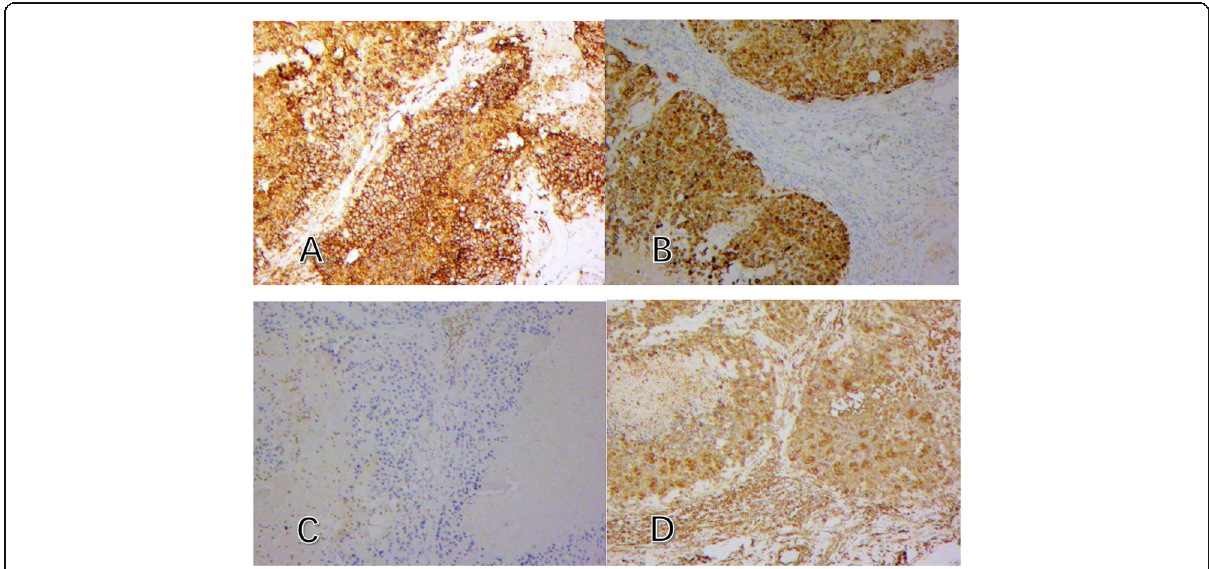
Fig. 5 IHC of the right axillary lymph nodes. a CD34 positive (× 100). b CK (pan) positive (× 100). c INI1negative (× 100). d Vimentin positive (× 100)